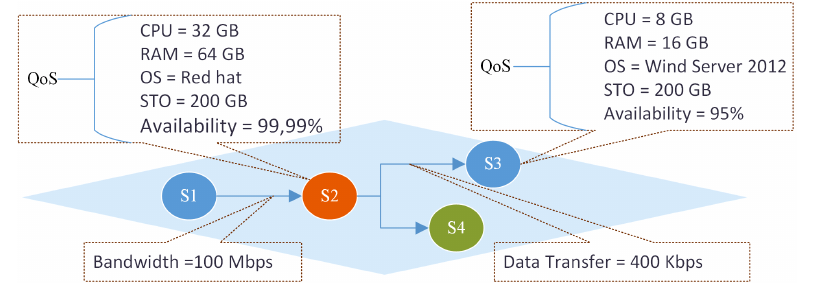
Fig. 3. User Service Request